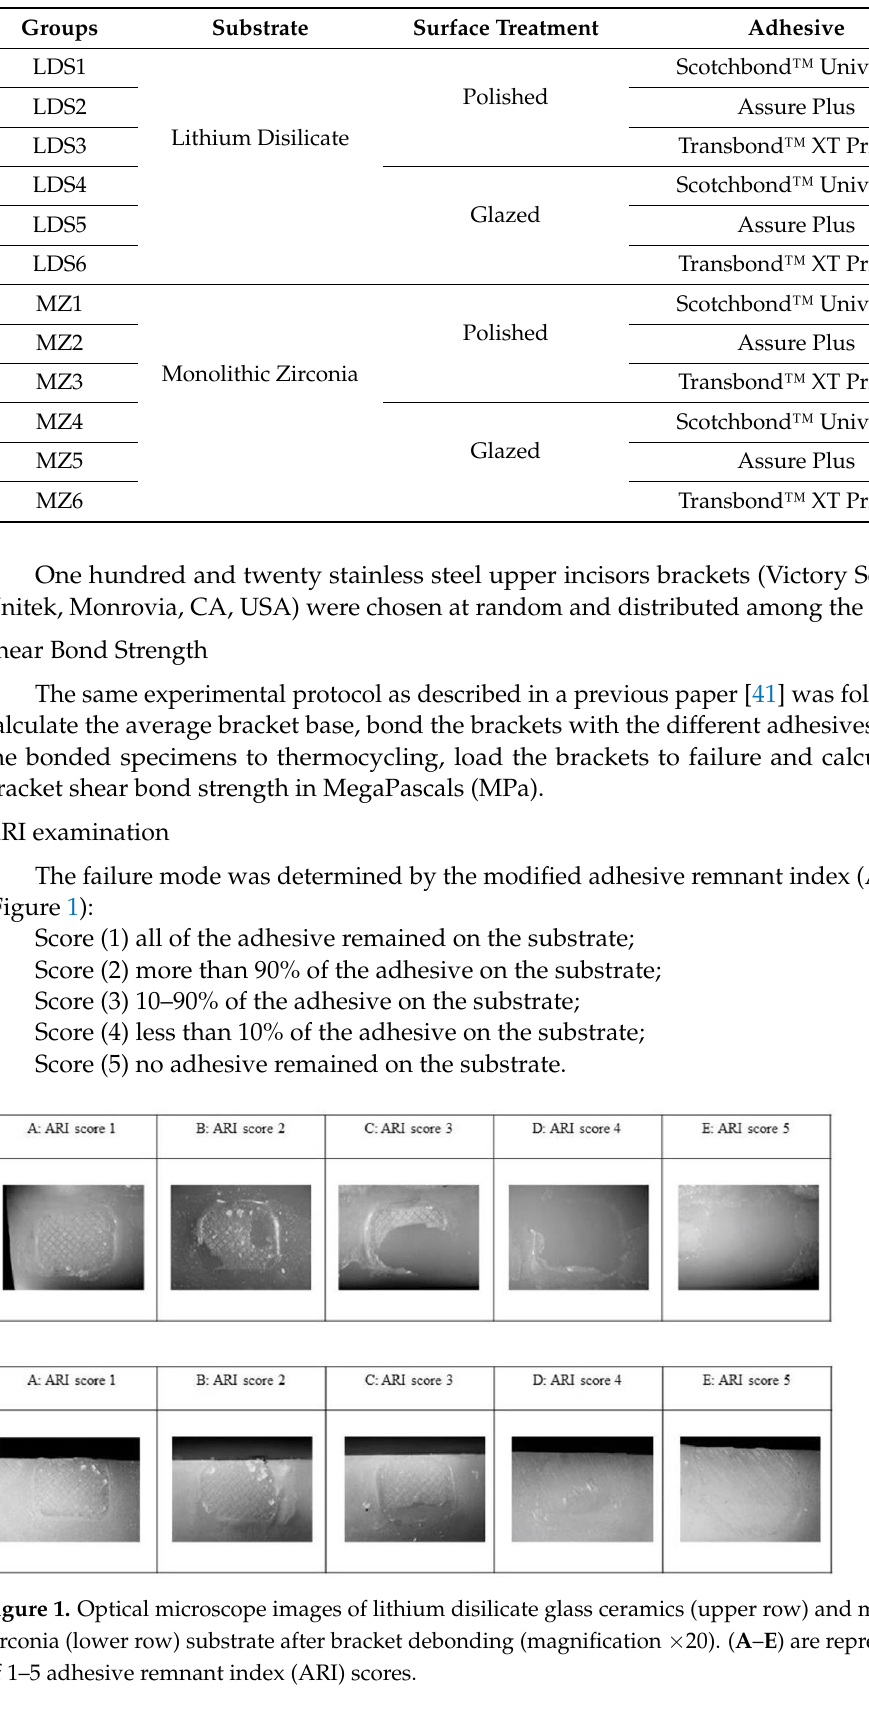
Table 2. Experimental groups.